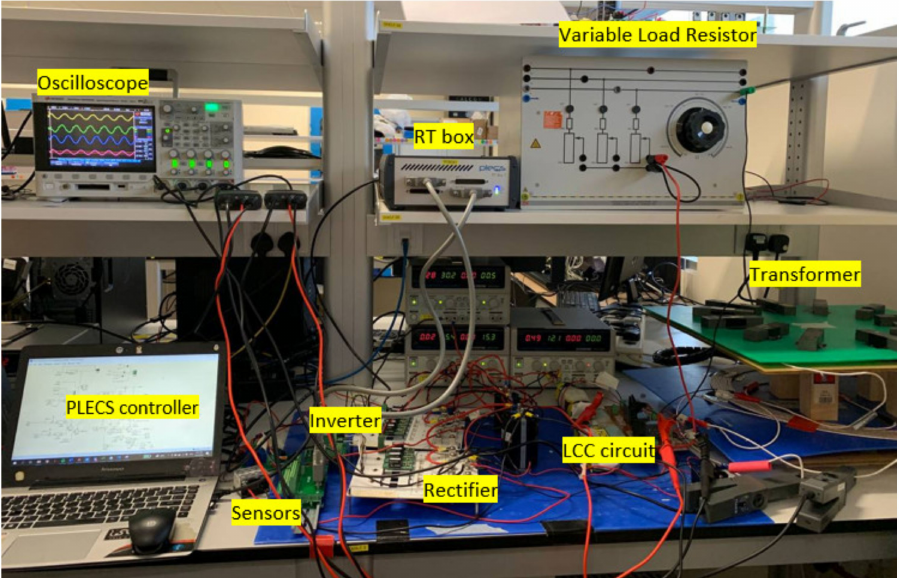
Figure 18. Experimental setup for DAB LCC resonant converter TPS control system.